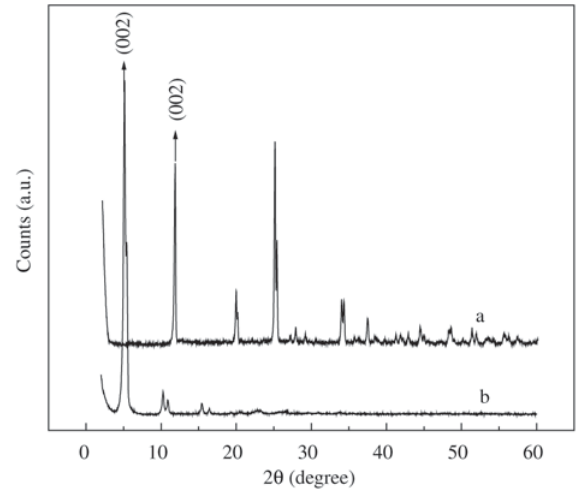
Figure 1. a) X-ray diffraction patterns of α -ZrP; b) α -ZrP/n- propylamine dried at 50